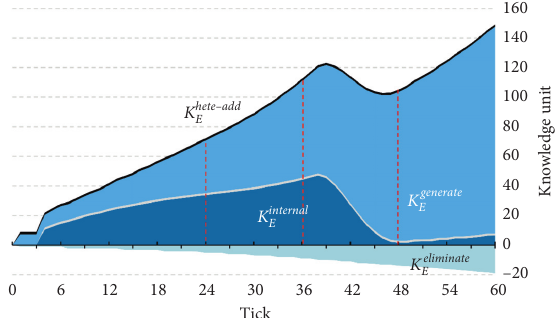
Figure 7: Agent E heterogeneous knowledge increment